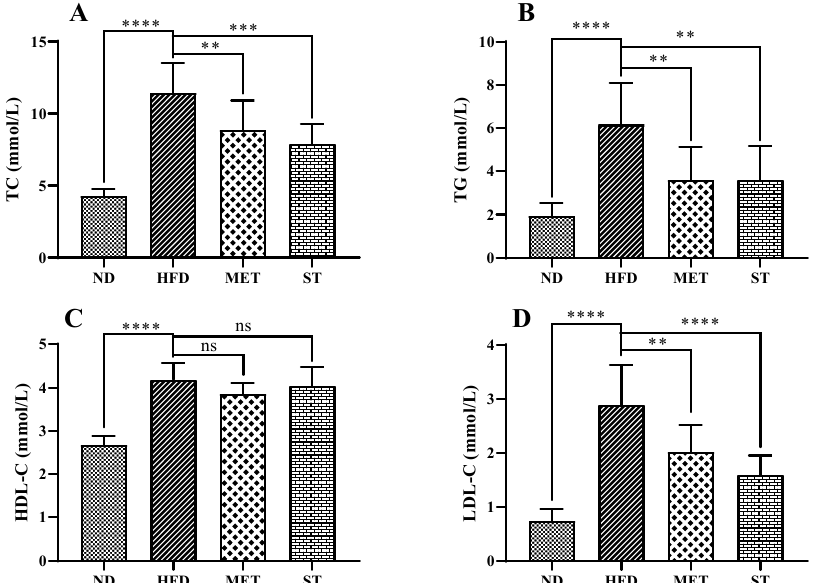
Figure 3. Effects of methanol extract of fermented green tea and spore suspension on TC ( A ), TG ( B ), HDL-C ( C ), LDL-C ( D ) levels in the serum of hamsters for 2 consecutive weeks of intervention. Statistical significance of differences between groups was determined using Ordinary one-way ANOVA. Data are expressed as mean ± SD ( n = 10). ** p ≤ 0.01; *** p ≤ 0.001; and **** p ≤ 0.0001 . “ns” indicates not significant ( p > 0.05).